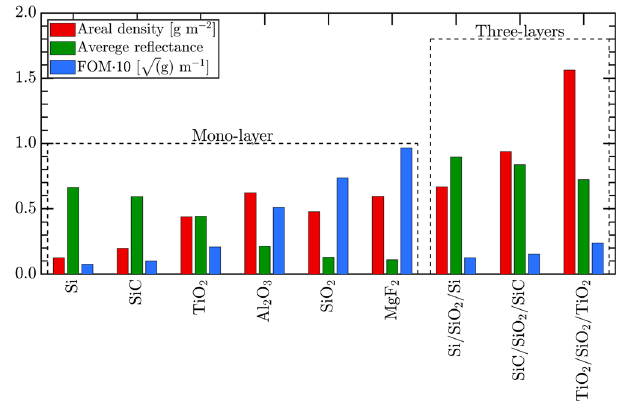
Fig. 4 Lightsail acceleration time versus laser irradiance. The acceleration time to reach β f in the beamer reference frame is shown for the lightsail structures considered in